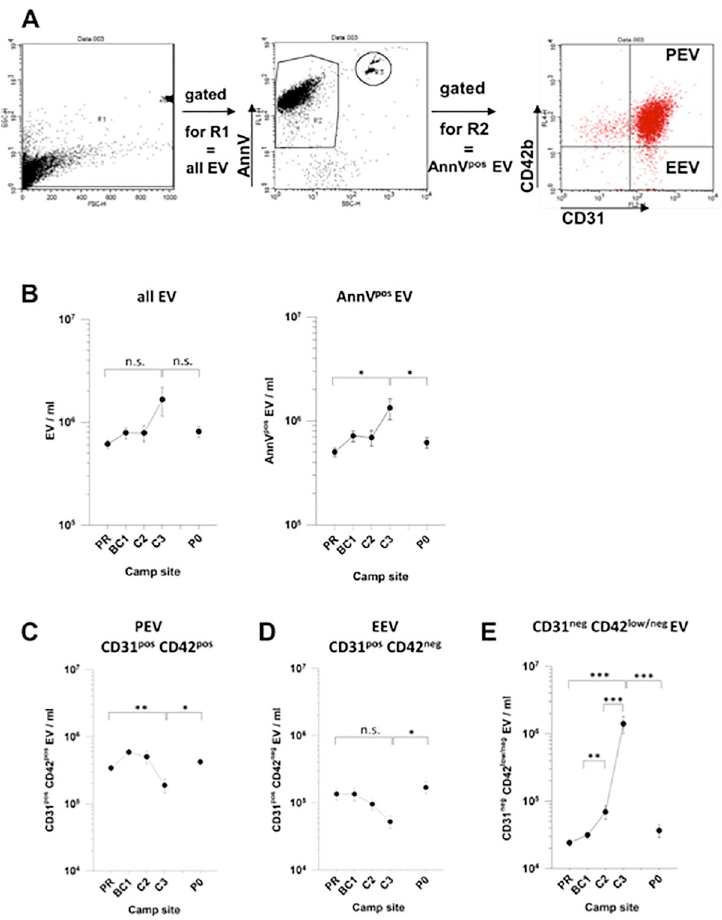
Fig 1. Extracellular vesicle contents in the plasma of mountaineers over the course of the high altitude expedition. Defined extracellular vesicle types were quantified by flow cytometry in plasma samples drawn from mountaineers at the indicated camp sites. (A) Gating strategy for identification of PEV and EEV among AnnexinV pos extracellular vesicles by expression of CD31 and CD42b. (B) Plasma contents of total EV (left panel) and AnnexinV pos EV (right panel). (C-E) Plasma contents of (C) CD31 pos CD42b pos PEV, (D) CD31 pos CD42b neg EEV, and (E) CD31 neg CD42b low/neg EV emerging at high altitude beyond 6.000 m asl. Shown are means +/- SE of data from all individuals reaching the indicated camp sites. Statistical significance is indicated by “ � ”, “ �� ”, or “ ��� ” representing p-values